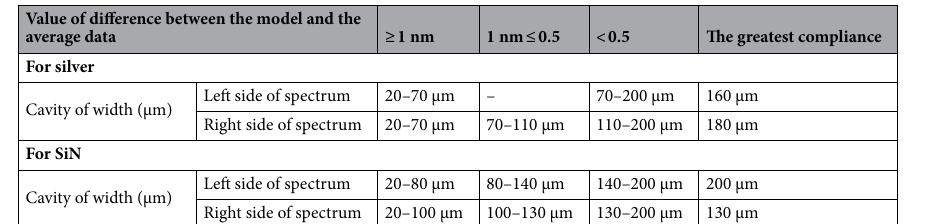
Value of difference between the model and the average